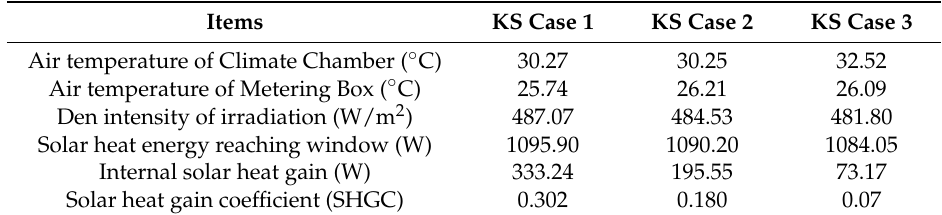
Table 5. Test items and